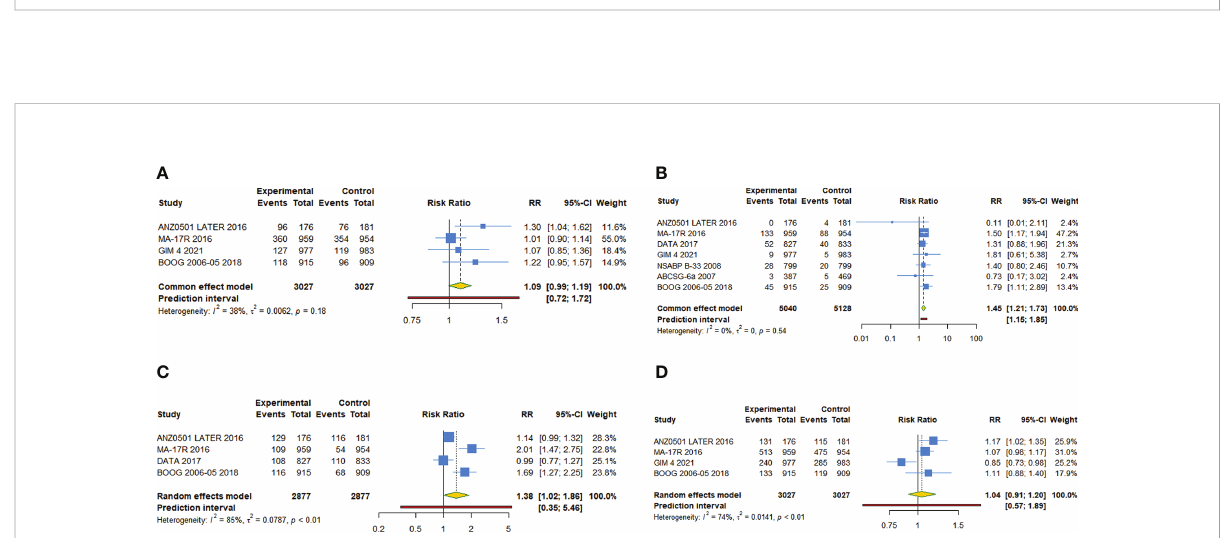
FIGURE 5 Forest plot of meta-analysis of extended adjuvant endocrine therapy for adverse events. (A) Hot fl ashes, (B) bone fracture, (C) osteoporosis, (D)